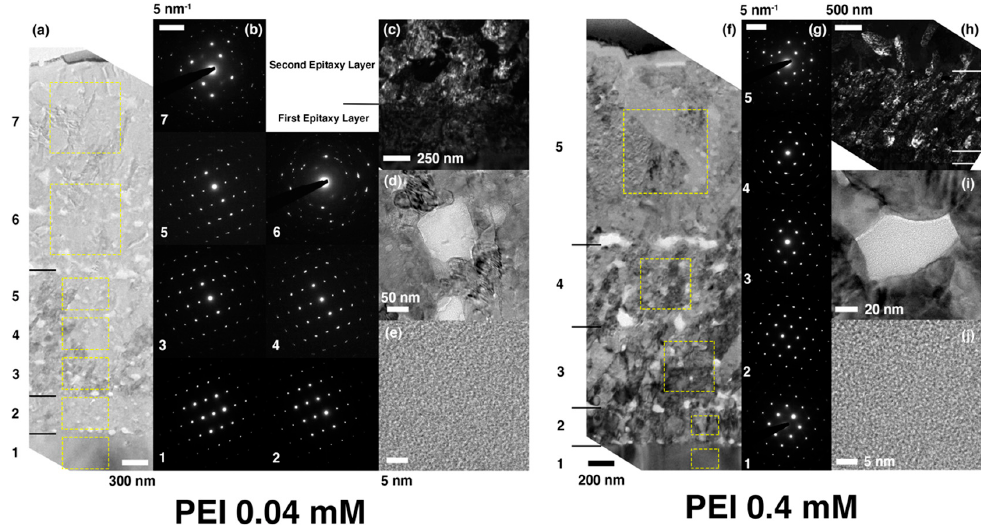
Figure 6. The microstructural and crystallographic characteristics of the coatings grown with ( a – e ) 0.04 mM and ( f – j ) 0.4 mM of PEI, respectively. ( a ) The bright-field TEM image showing the entire coating cross section of the sample with 0.04 mM of PEI and ( b ) corresponding selected area electron diffraction patterns obtained in the area within each dotted yellow box in ( a ). ( c ) The dark-field TEM image showing the first few sub-layers above the substrate. ( d ) The bright-field TEM image showing one of the brightly-contrasted spots in ( a ). ( e ) The high-resolution TEM image magnifying the bright spot in ( d ). ( f ) The bright-field TEM image showing the entire coating cross section of the sample with 0.4 mM of PEI and ( g ) corresponding selected area electron diffraction patterns obtained in the area within each dotted yellow box in ( f ). ( h ) The dark-field TEM image showing the first a few sub-layers above the substrate. ( i ) The bright-field TEM image showing one of the brightly-contrasted spots in ( f ). ( j ) The high-resolution TEM image magnifying the bright spot in ( i ). In order to investigate the epitaxial relationship of the coated layer, the electron diffraction patterns in ( b ) and ( g ) were obtained without adjusting the specimen tilting angles once they are fixed along the zone axis of the substrate.